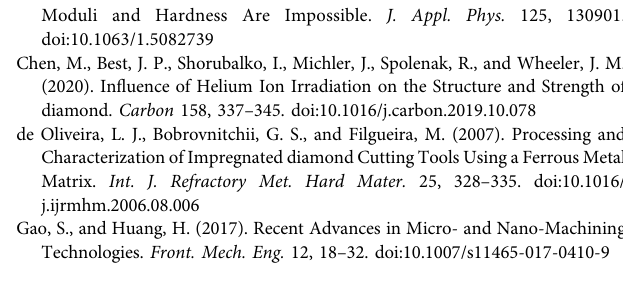
Frontiers in Materials |